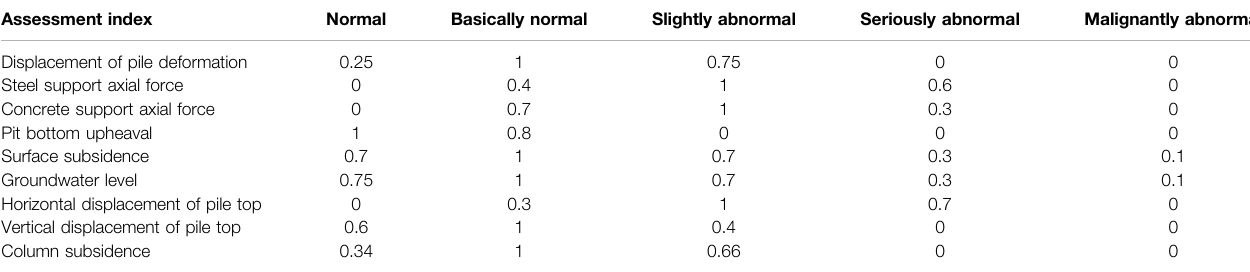
TABLE 3 | Assessment table of membership degree of the nine selected assessment indexes.